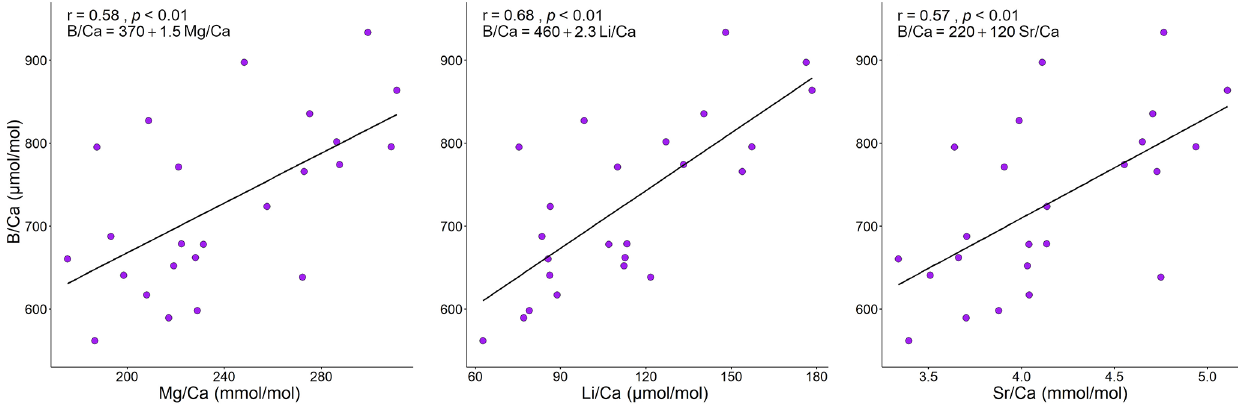
Figure 8. Correlation plots of B / Ca with Mg / Ca, Li / Ca, and Sr / Ca in L. corallioides collected in Morlaix Bay. For each analysis the Spearman’s coefficient r , the p value, and the line equation are